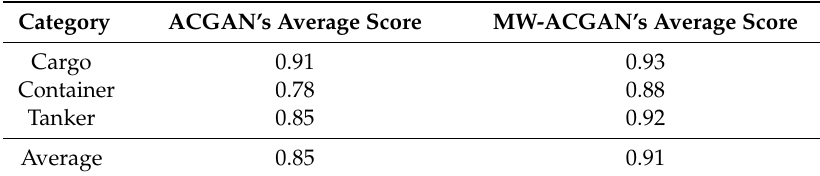
Table 3. ResNet18 scores of the ACGAN and the